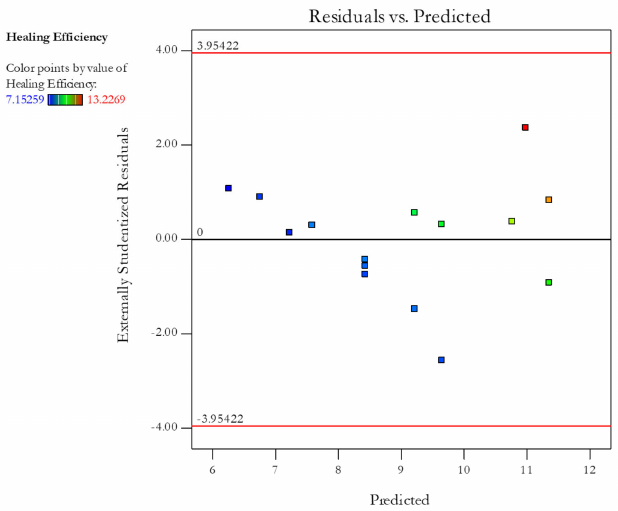
Figure A3. Plot of the residuals versus the predicted response